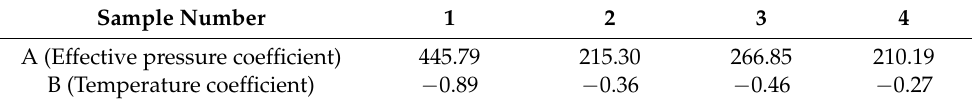
Table 3. Fitting coefficients of four